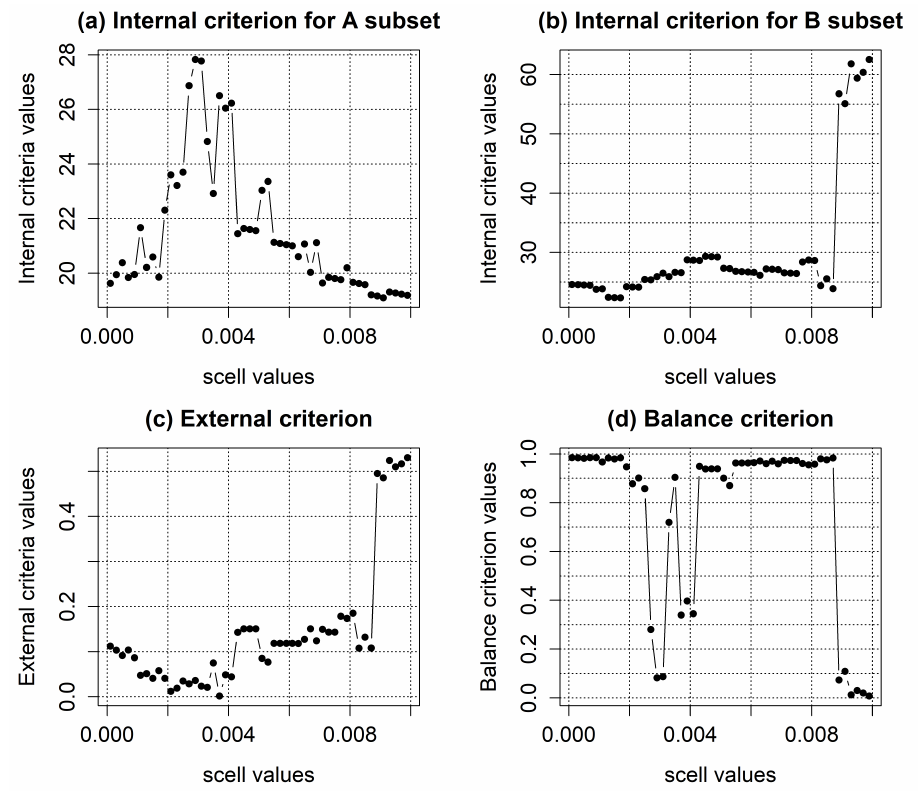
Figure 5. The simulation results for determining the optimal parameters of the SOTA clustering algorithm based on the application of inductive methods of complex systems